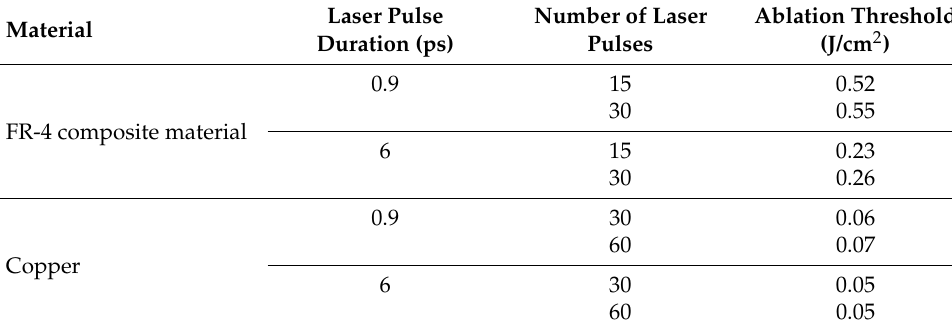
Table 2. Ablation threshold results for FR-4 composite material and copper at different laser pulse durations and number of applied laser